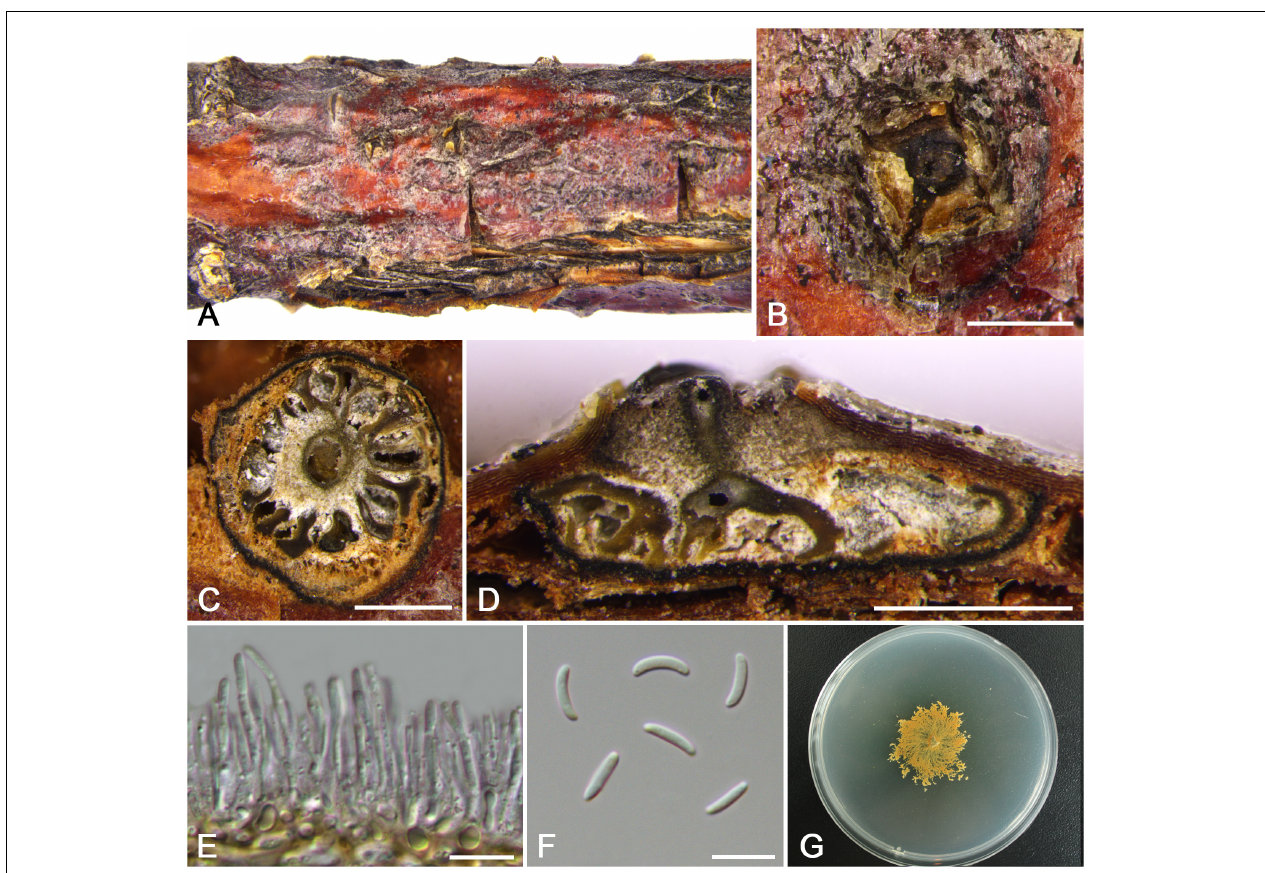
FIGURE 7 | Morphology of Cytospora ochracea from Cotoneaster sp. (CF 20197684). (A,B) Habit of conidiomata on twig. (C) Transverse section of conidioma. (D) Longitudinal section through conidioma. (E) Conidiophores and conidiogenous cells. (F) Conidia. (G) Colonies on PDA for 2 weeks. Bars: (B–D) = 500 µ m; (E,F) = 10 µ